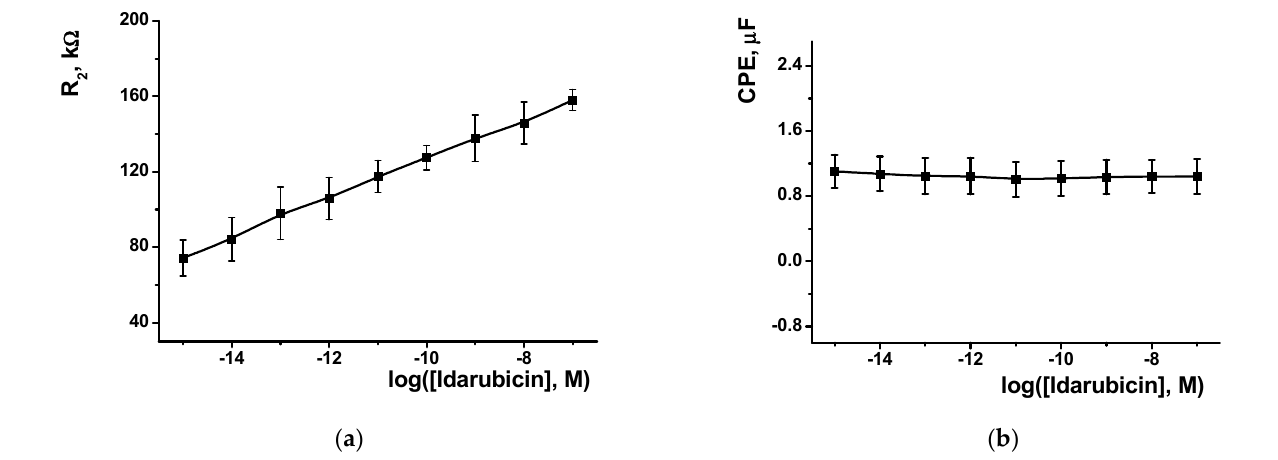
Figure 11. ( a ) Charge transfer resistance, and ( b ) constant phase element dependence on idarubicin concentration in PAB-2/DNA-MB, EIS, 0.1 M HEPES buffer containing 0.03 M NaCl, pH 7.0 in the presence of an equimolar mixture of 0.01 M [Fe(CN) 6 ] 3 − and [Fe(CN) 6 ] 4 − ions. Results are mean ± S.D. obtained from 6 independent experiments. Six PAB-2/DNA-MB sensors were used to assess the signal reproducibility. The linear range of concentrations was from 1 fM to 100 nM of idarubicin with LOD 0.3 fM, so it was extended for three orders of magnitude compared to voltammetry (Equation (5)). The LOD value was evaluated as S/N = 3 criterion.